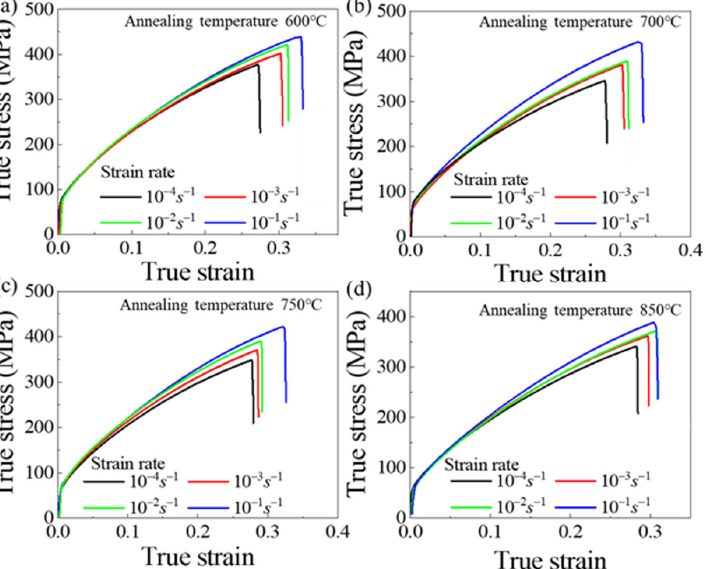
Figure 5. True stress–strain curves of specimens with different annealing conditions at various strain rates: ( a ) 600 °C, ( b ) 700 °C, ( c ) 750 °C, and ( d ) 850 °C.